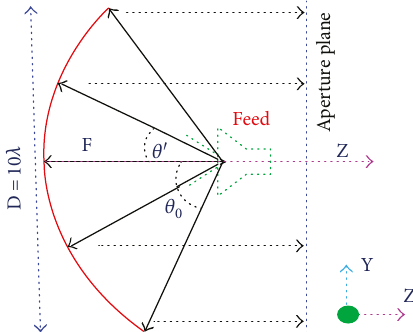
Figure 1: Basic principle of the parabolic re fl ector.